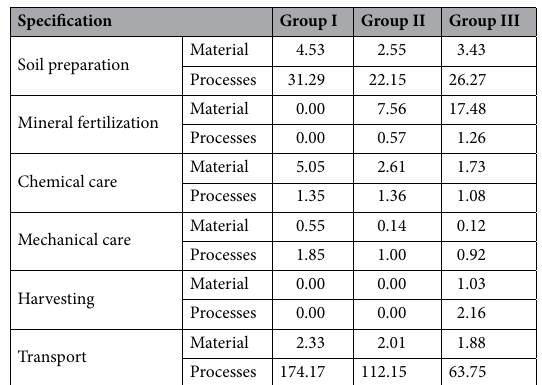
Table 9. Structure of CO 2 emissions in area groups (kg CO 2 ·GJ −1 ).